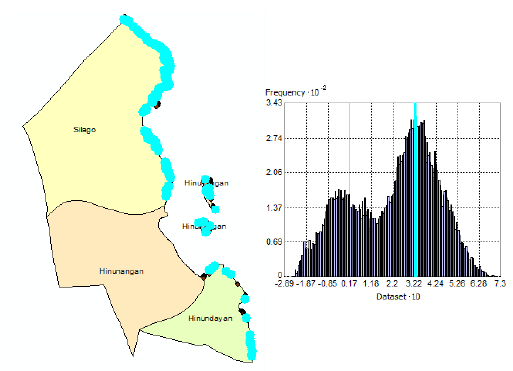
Figure 9. Location of high NDVI values in December